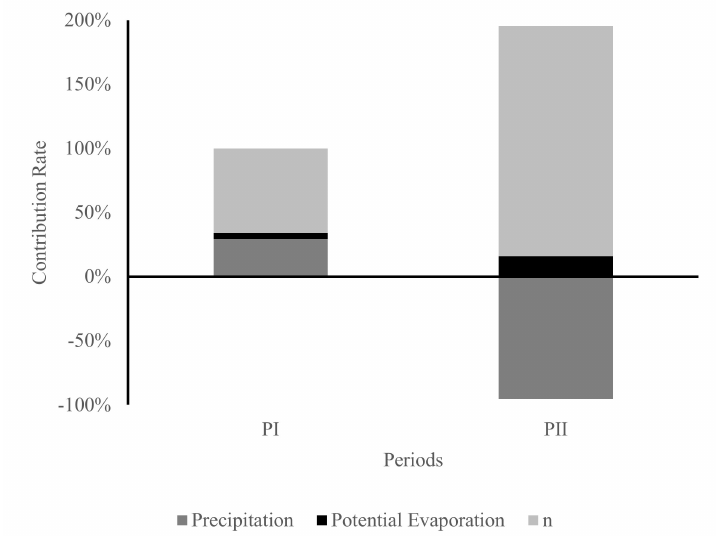
Figure 4. Contribution of various factors to runoff changes in the Weihe River